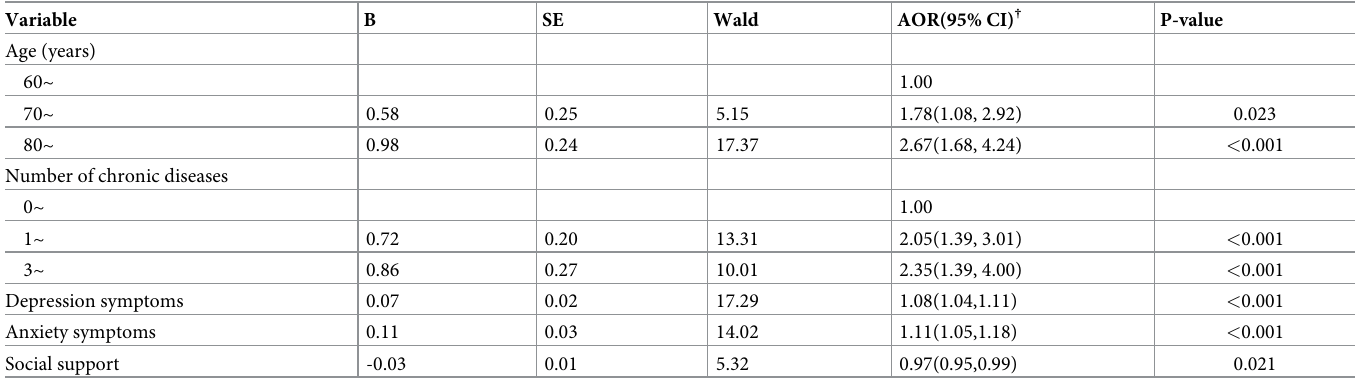
Table 4. Risk factors for poor sleep quality among the elderly in nursing homes.